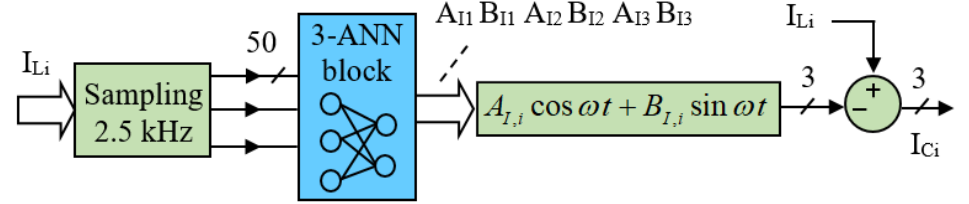
Figure 2. Harmonic compensation: generation of the APF reference currents based on the Fourier coefficients provided by the ANNs.